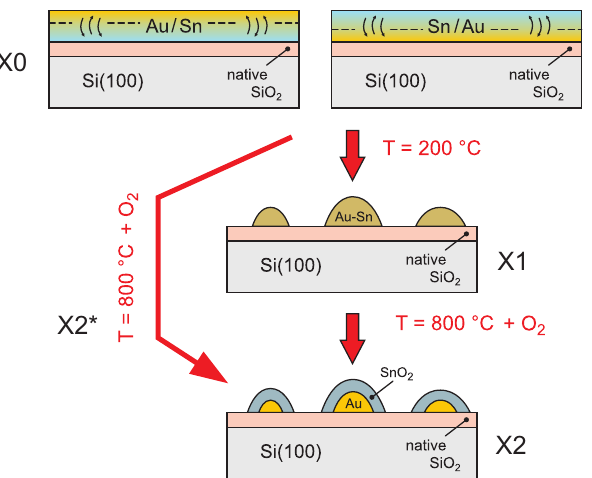
Figure 1. A scheme of the method of fabrication of nanostructural thin films through the oxidation of Au–Sn intermetallic compounds. X = A, B, C, or D. Table 1. The samples produced: id., layered structure of a sample, the atomic ratio (Au:Sn), the tempera- ture of annealing ( T a ), and the temperature of oxidation ( T o ).